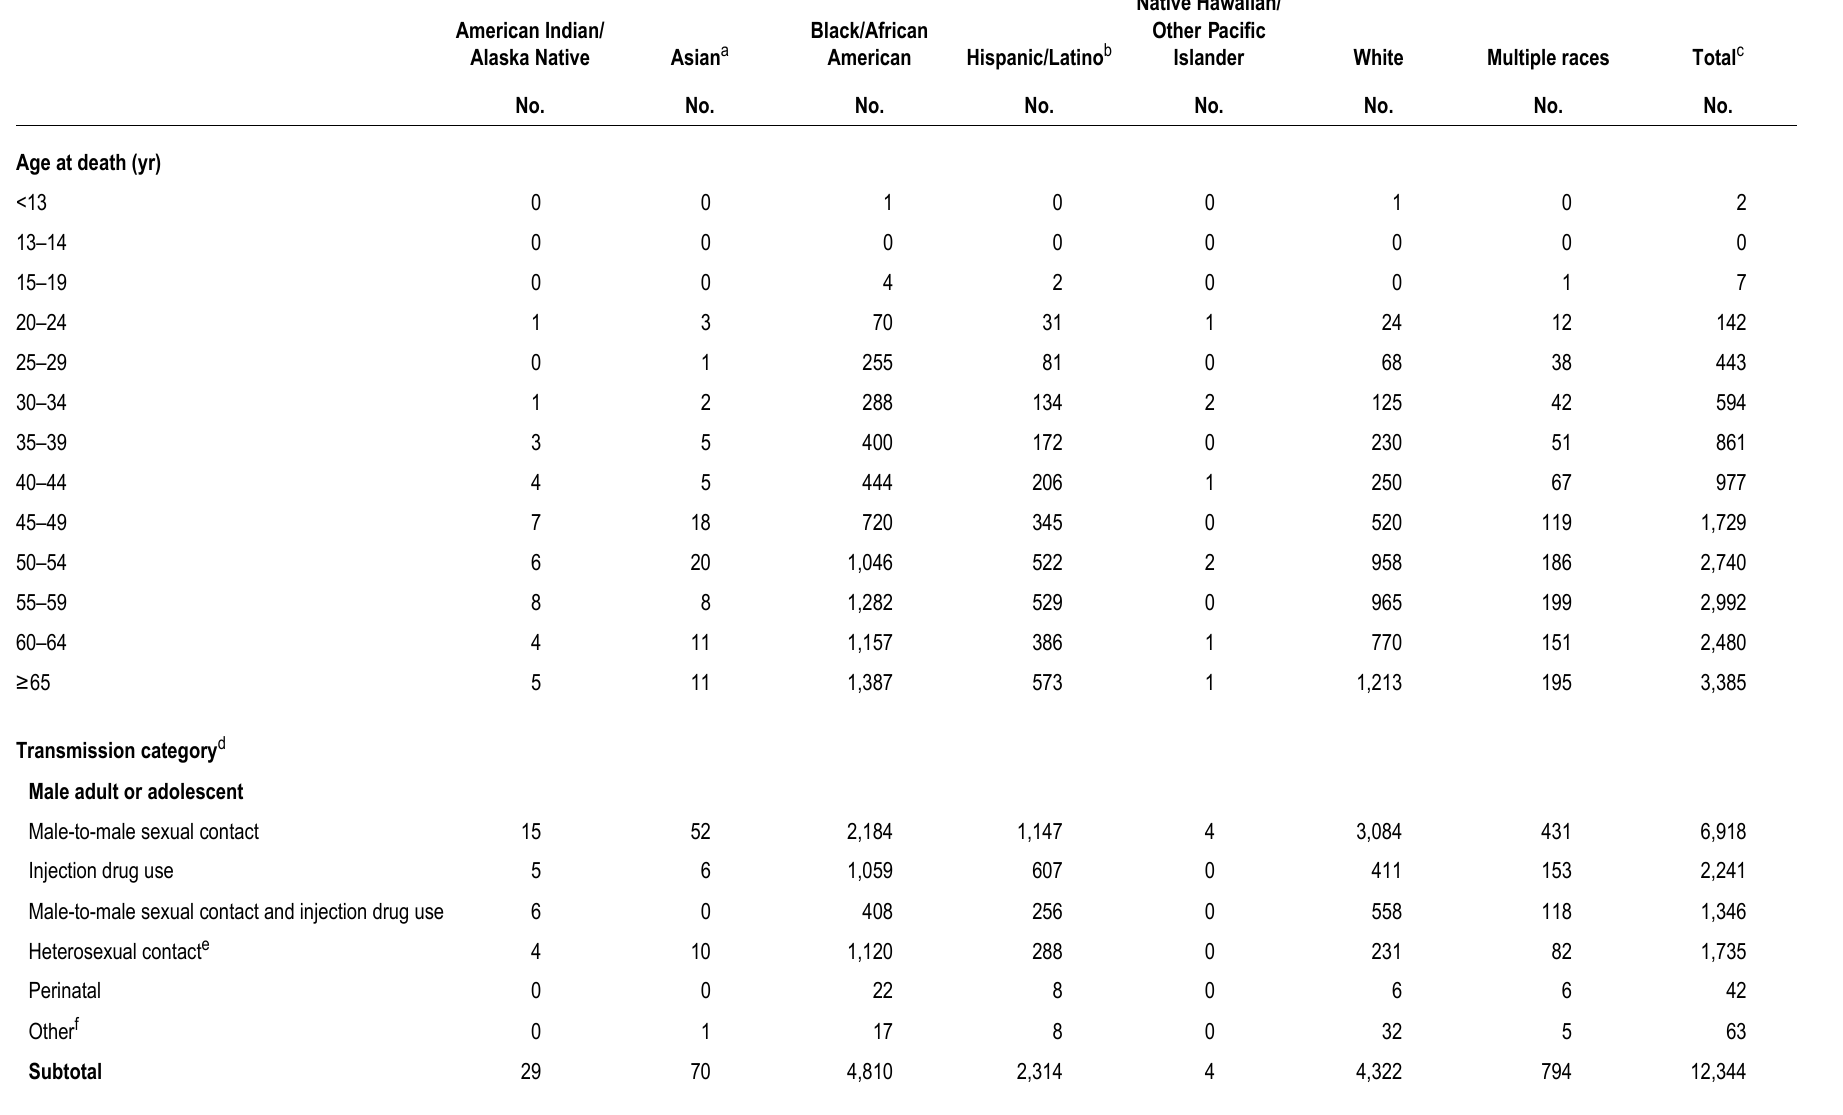
Table 20b. Deaths of persons with diagnosed HIV infection, by race/ethnicity and selected characteristics, 2017—United States and 6 dependent areas Native Hawaiian/ American Indian/ Black/African Other Pacific Alaska Native Asian a American Hispanic/Latino b Islander White Multiple races Total c No. No. No. No. No. No. No.